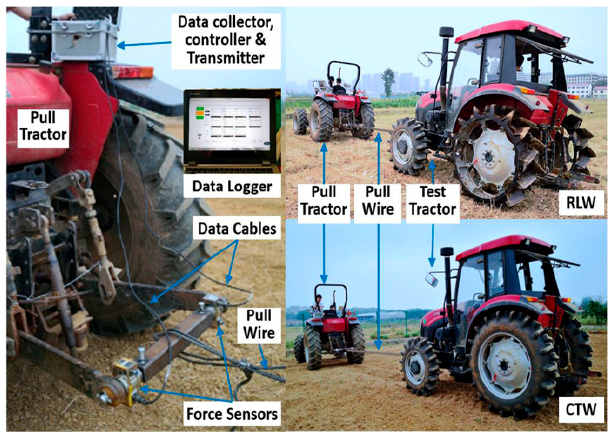
Figure 2. Tractors and force measuring instrument setup for motion resistance measurement.